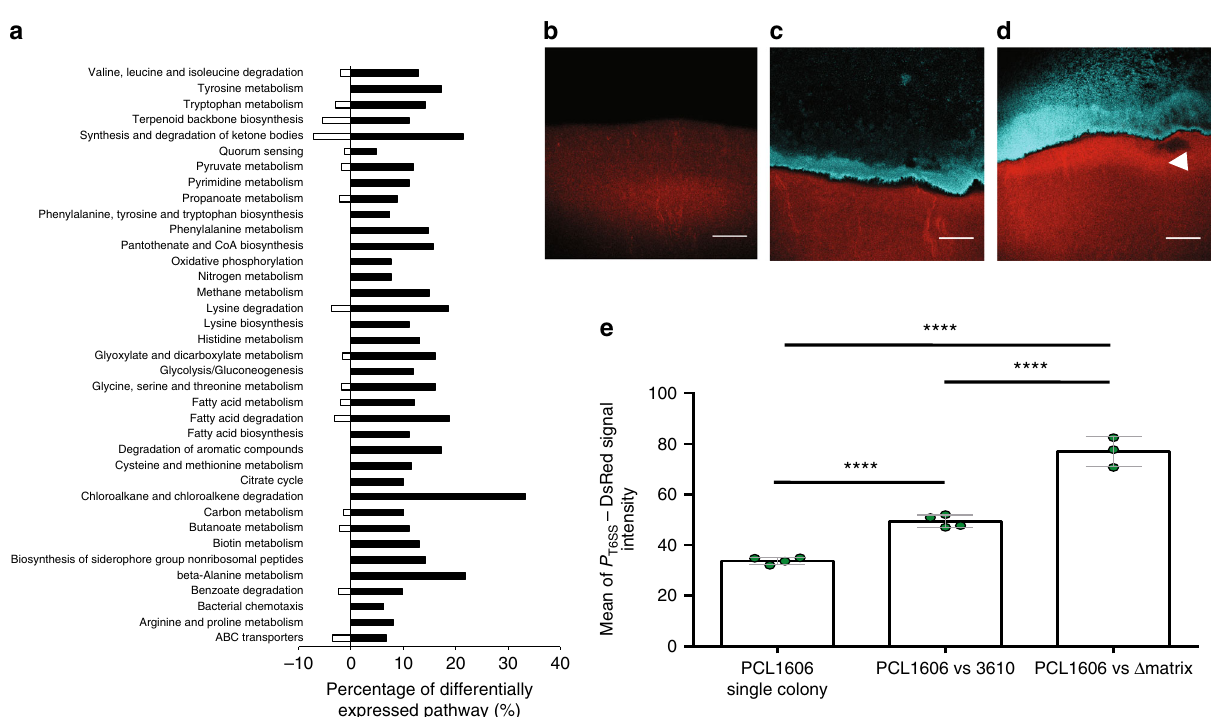
Fig. 6 PCL1606 activates the T6SS upon contact with B. subtilis Δ matrix. a KEGG pathway analysis of the PCL1606 genes induced (black bars) and repressed (empty bars) after 72 h of interaction with Δ matrix. b – d Confocal scanning laser microscopy images of b the leading edge of PCL1606 P T6SS - DsRed single colony, c intermediate area of the interaction between PCL1606 P T6SS -DsRed colony and 3610 labeled with CFP, and d the interaction PCL1606 P T6SS -DsRed vs Δ matrix labeled with CFP after 72 h of growth. White arrows highlight the areas where P T6SS is induced. Scale bar, 100 µ m. e Measurement of the fl uorescence intensity in the PCL1606 leading edge when growing alone or interacting with Bacillus strains. ( n = 4). **** P value < 0.0001 ( t student). Source data are provided as a Source Data fi